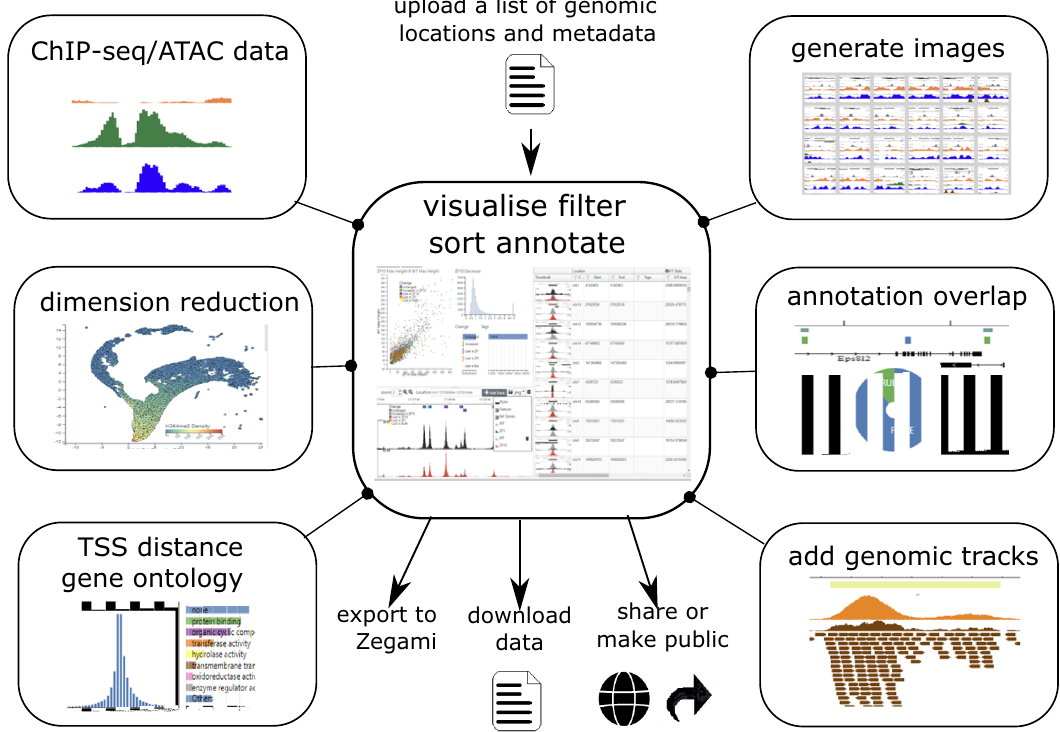
Fig. 4 Summary of MLV Work fl ow. Initially a BED or BED-like fi le of genome locations is uploaded, which can be visualised via a spreadsheet, browser and various interactive graphs. A number of analyses can also be carried out on the uploaded locations in order to further explore the data. These include calculating distances from genomic objects such as TSSs, overlap with genomic features, calculating signal data at each location from bigWig e.g. ChIP or ATAC-seq and dimensionality reduction values, to produce interactive t-SNE 17 or UMAP 16 representations of the data. To aid interpretation, genome tracks of other datasets and dynamic graphs can be added and browser images for each location can be generated, which can be viewed in a table format. The analysis can be downloaded as csv/tab delimited text or shared/made public via a URL. A collection can also be created in the analysis software Zegami for further interrogation of the